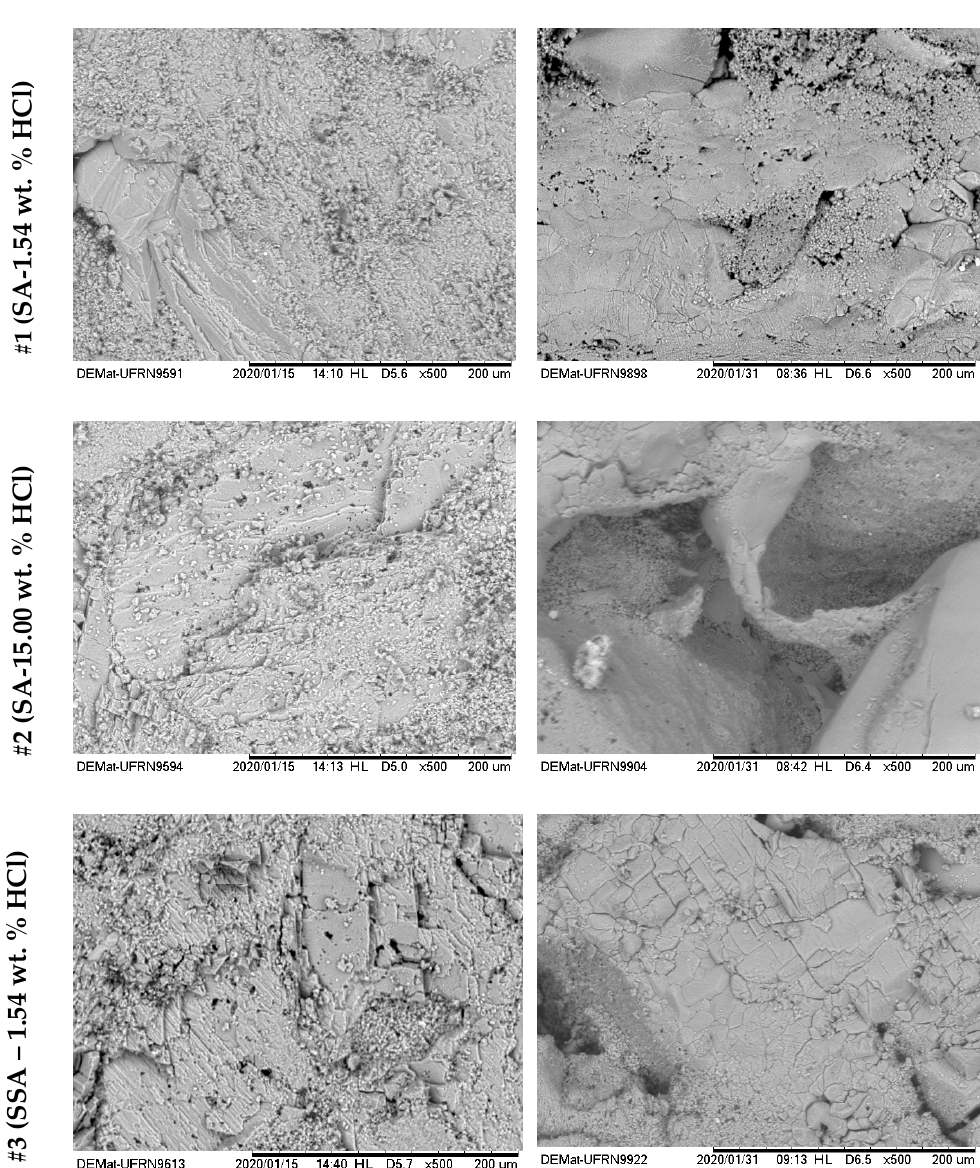
Figure 16. SEM photographs with 500 × magnification in Indiana limestone, for systems SA-1.54 wt. % HCl (#1), SA-15.00 wt. % HCl (#2) and, SSA-1.54 wt. % HCl (#3), before and after contact angle measurement.